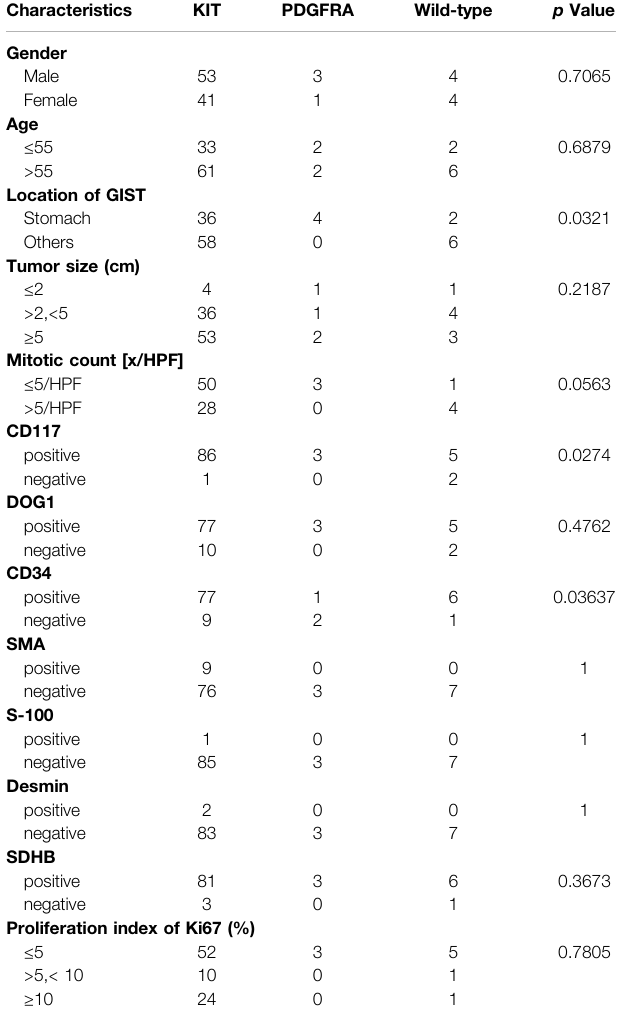
TABLE 3 | Clinicopathological feature correlation with molecular classi fi cation. Characteristics